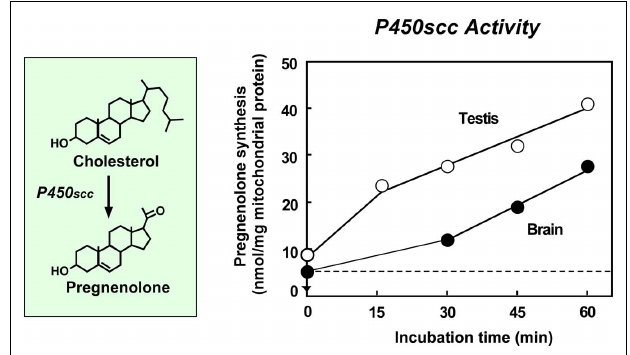
FIGURE 1 | Pregnenolone formation from cholesterol in the quail brain. Biochemical analysis of the formation of pregnenolone from cholesterol using intact mitochondria derived from the quail brain. Incubations were performed with 200 μ M cholesterol, 0.25mg of mitochondrial protein, 10mM isocitrate and 10mM succinate at 41˚C for different times. See Tsutsui andYamazaki (1995) for